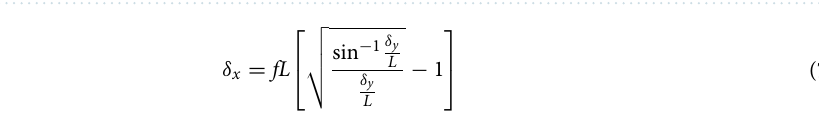
Figure 8. Photographs of the bending of the triangular cantilevers due to a concentrated load at the tip. Results are shown for triangular cantilever base width b of ( a ) 22 mm, ( b ) 47 mm, ( c ) 69 mm, ( d ) 95 mm, and ( e ) 141 mm. In each case the length of the triangular cantilever is 190